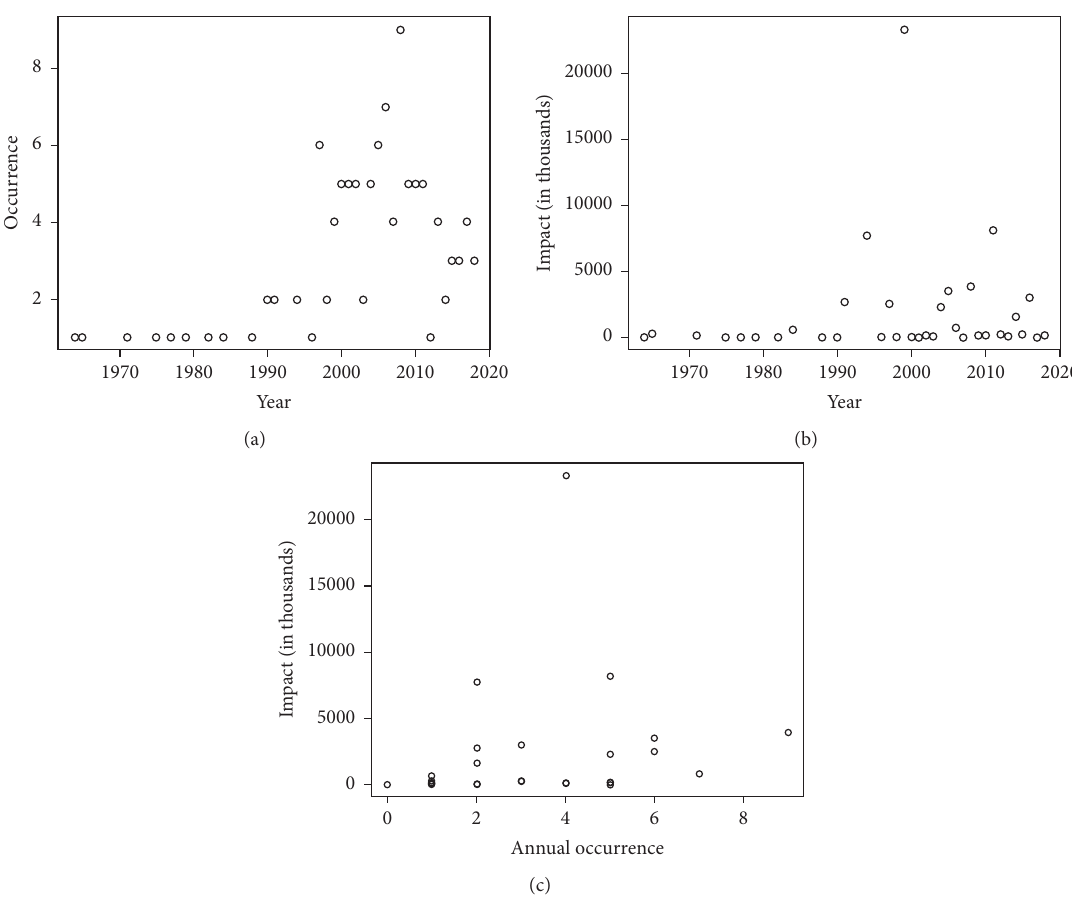
Figure 1: Scatter plots to check for independence. (a) Annual occurrence against the corresponding years. (b) Annual severity against the corresponding years. (c) Annual occurrence against annual severity.